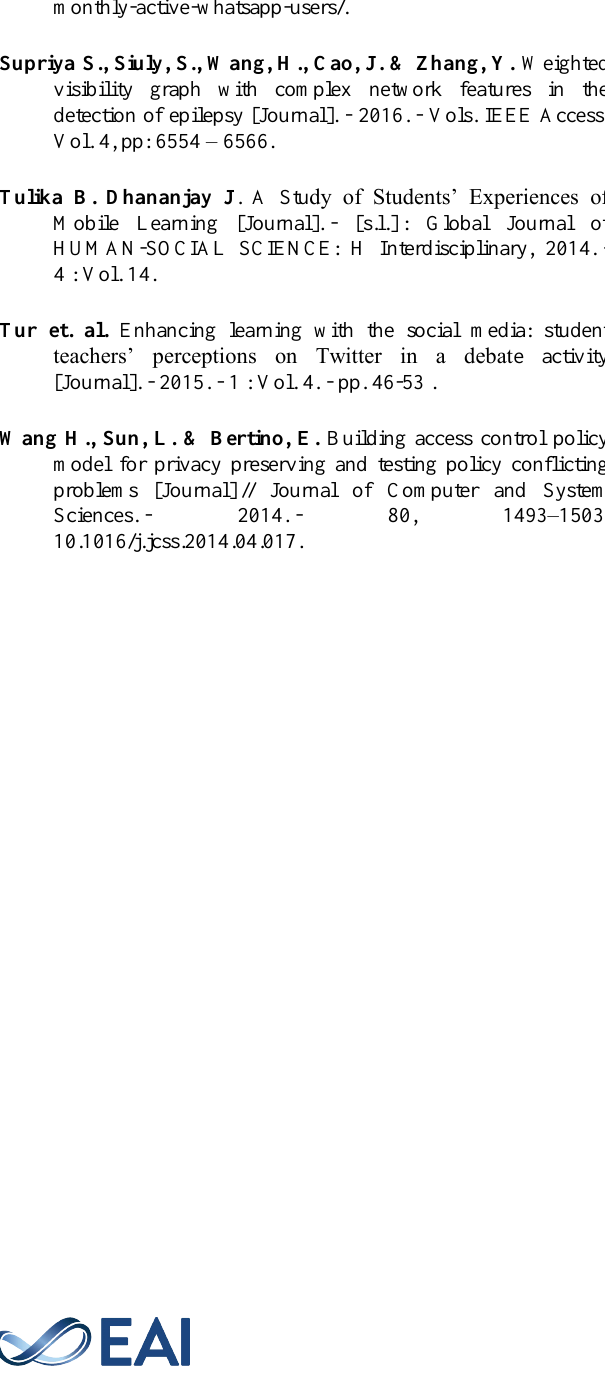
EAI Endorsed Transactions